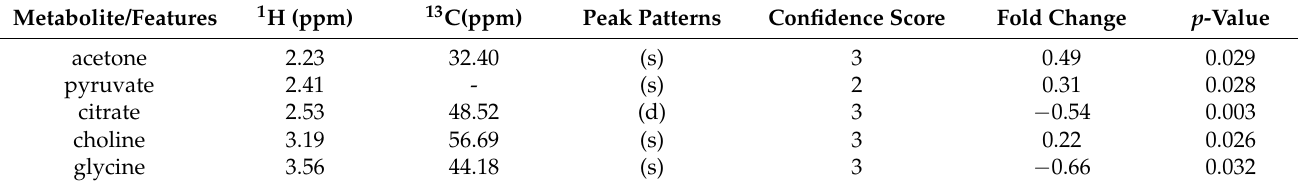
Because NMR metabolomic features were underrepresented in the initial dataset when compared to MS, and therefore less likely to be selected in the metabolite panel, we added